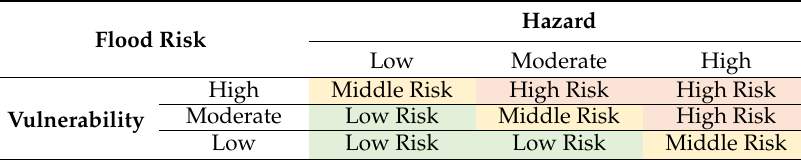
Table 2. Flood risk